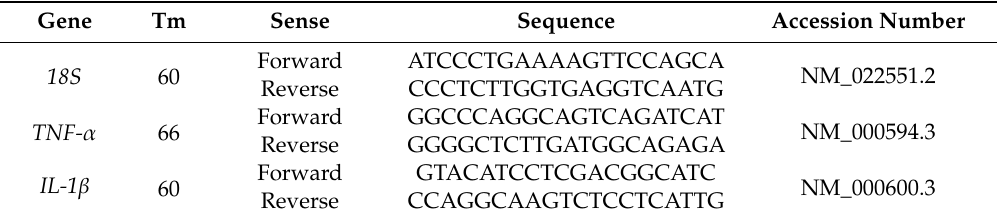
Table 1. Primer used for RT-qPCR